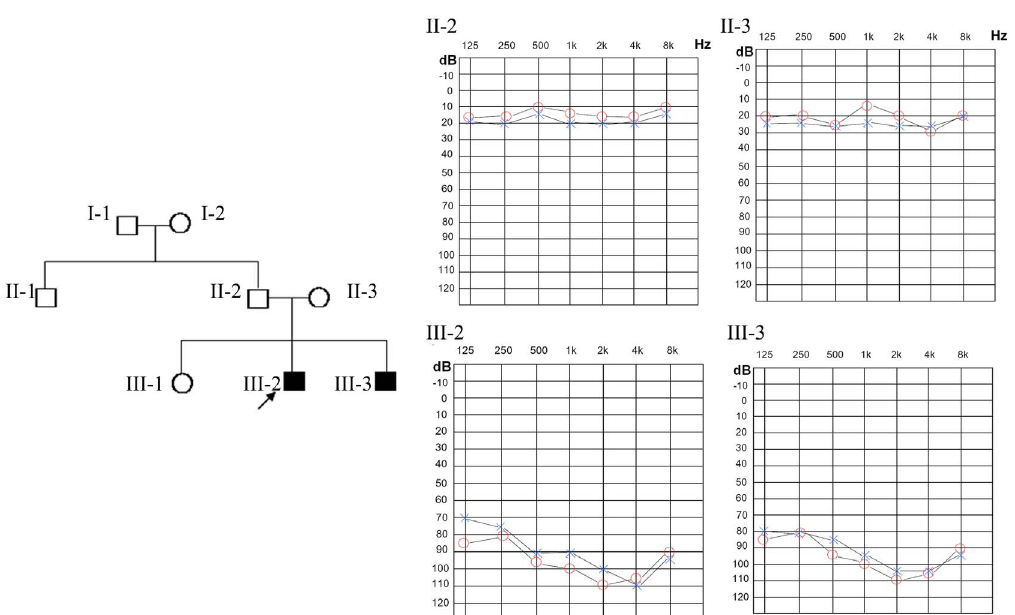
Figure 1. Family pedigree and relative audiograms. Audiograms of family members were obtained using pure tone audiometery with air conduction at frequencies from 250 to 8000 Hz. The proband’s parents, II-2 at age 41 and II-3 at age 39, showed normal hearing audiograms, while the affected brothers, III-2 and III-3, showed severe to profound hearing